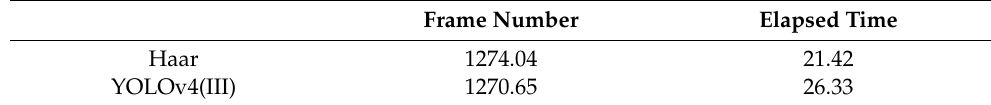
Table 6. Average of frame number and elapsed time with one run.